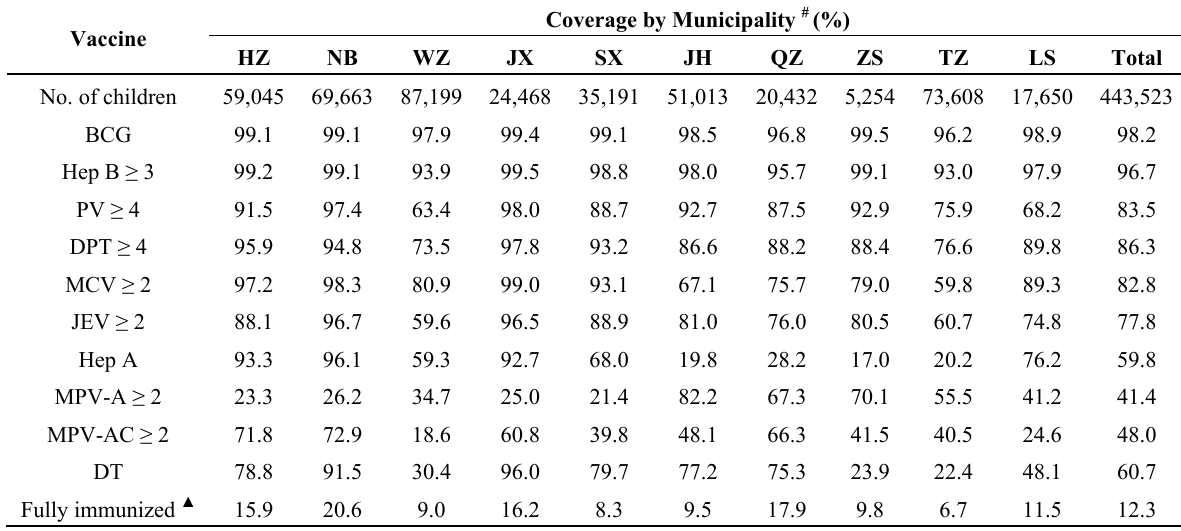
Coverage by Municipality # (%)